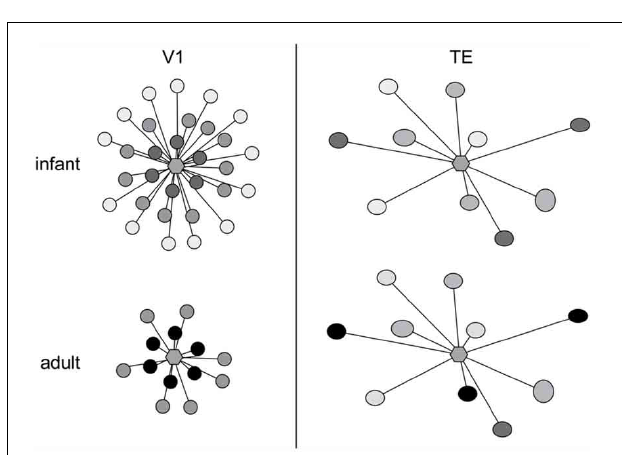
FIGURE 9 | Axon growth in development. Schematic illustration of the postnatal development of intrinsic axon patches in the primary visual area (V1) and visual association area TE in the macaque monkey. At center in each representation is a hexagon representing a single injection site. The shaded circles represent the intrinsic patches labeled by the single injection site. The intensity of labeling varied among patches, illustrated as varying shades of gray. Note that labeled patches were observed both in TE and V1 at 1 week of age (infant). Even at this age the size, interpatch distance and distribution pattern differ between the two cortical areas. The patterns of connectivity then diverge, resulting in qualitatively and quantitatively different patterns in the adult. In particular, the number and the maximal lateral extent of patches are reduced during postnatal development in V1, whereas in TE the number of patches remains constant and connectivity among these patches strengthens with aging. Based on data from Wang et al.